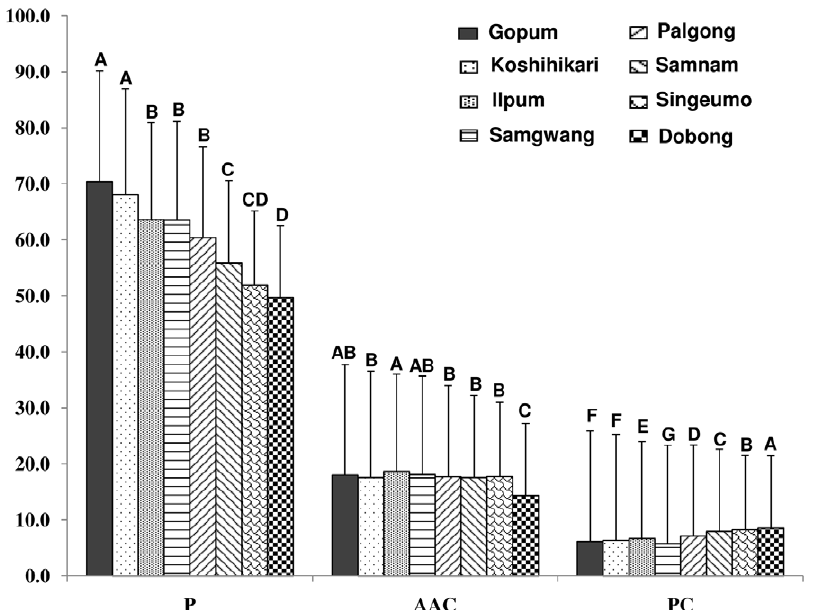
Figure 2. Palatability (P), apparent amylose content (AAC) (%), and protein content (PC) (%) in polished rice of eight japonica varieties. Letters A–F, difference is significant at 0.05 level.